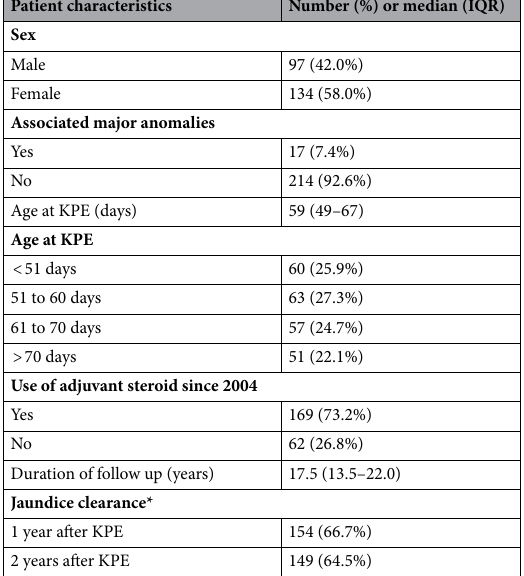
Number and % of patients achieving COJ at 1 year after